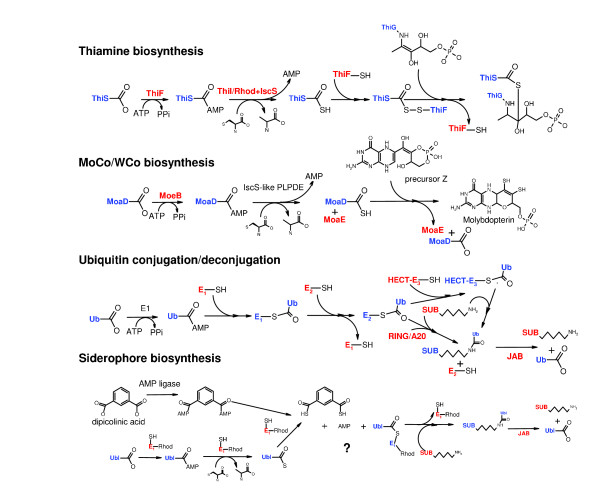
ThiS/MoaD/Ubiquitin-based protein conjugation system. The figure shows different themes by which a ThiS/MoaD/Ubiquitin-like polypeptide participates in thiamine biosynthesis, MoCo/WCo biosynthesis, and the ubiquitin conjugation/deconjugation system and the siderophore biosynthesis pathways. The '?' refers to the speculated part of the pathway inferred from operon organization. SUB refers to the polypeptide/protein substrate.